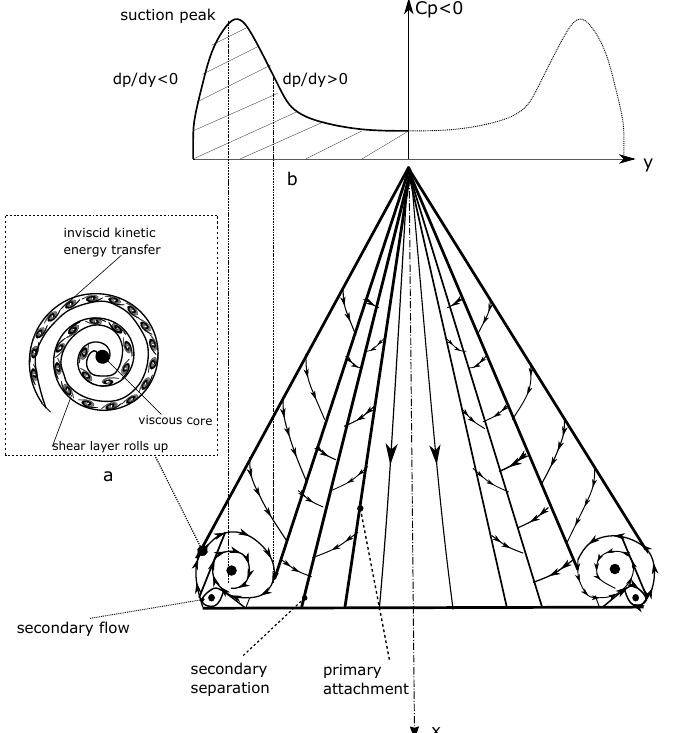
Figure 2. Streamline and flow topology over a DW: ( a ) details of the primary vortex; ( b ) windside pressure coefficient, c p